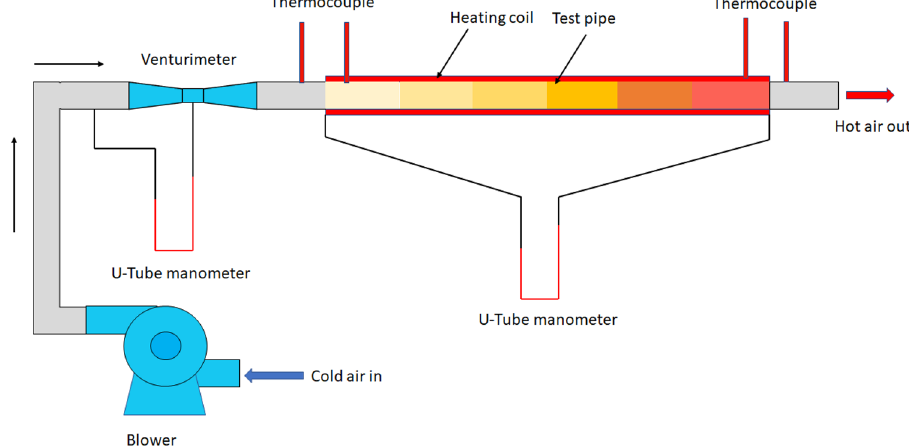
Fig. 1 Schematic diagram of the experimental